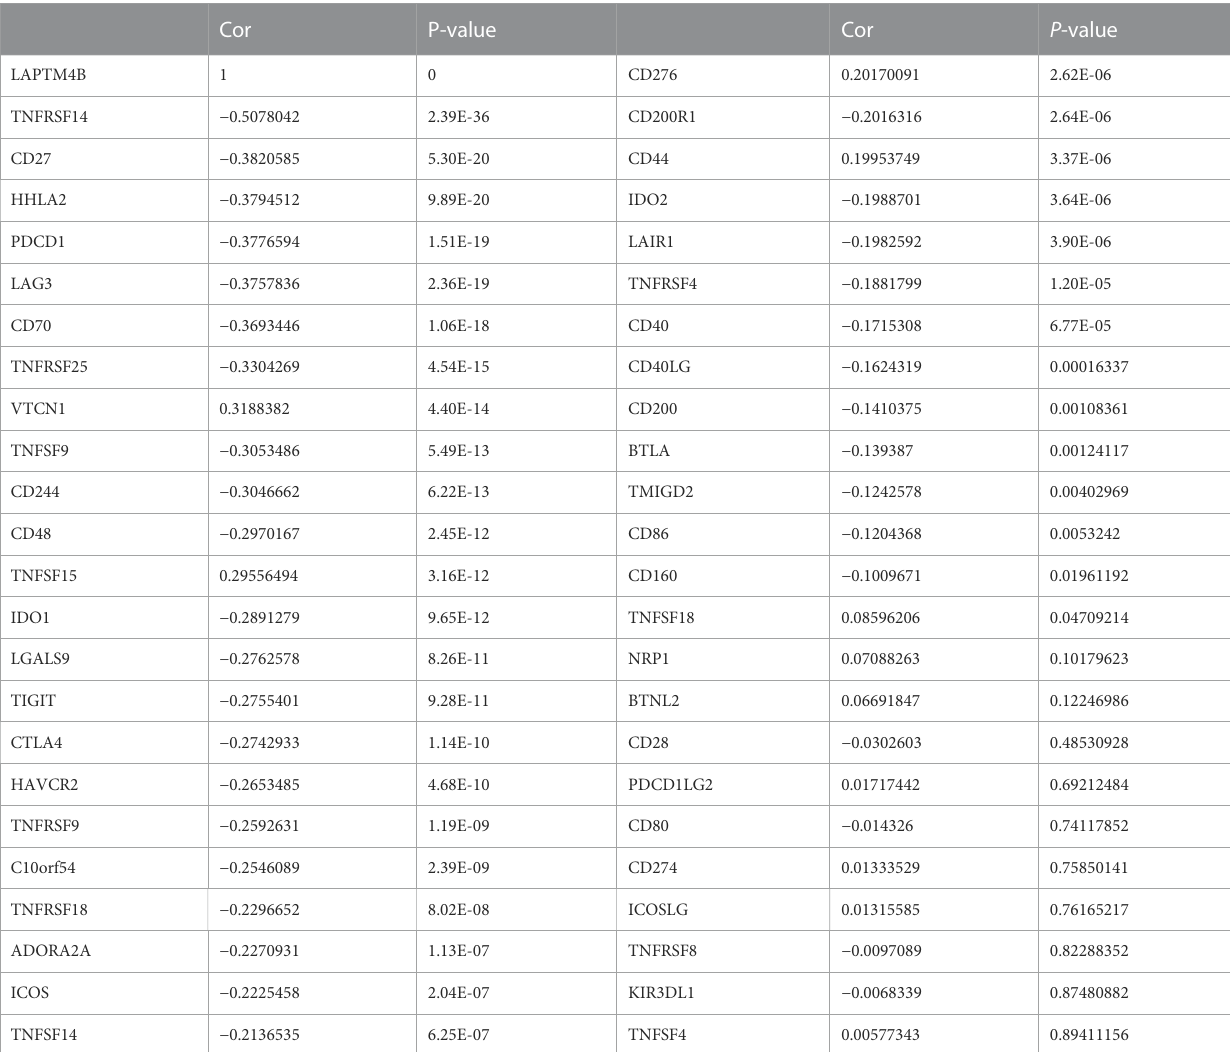
TABLE 1 Correlation between LAPTM4B and immune checkpoint genes.